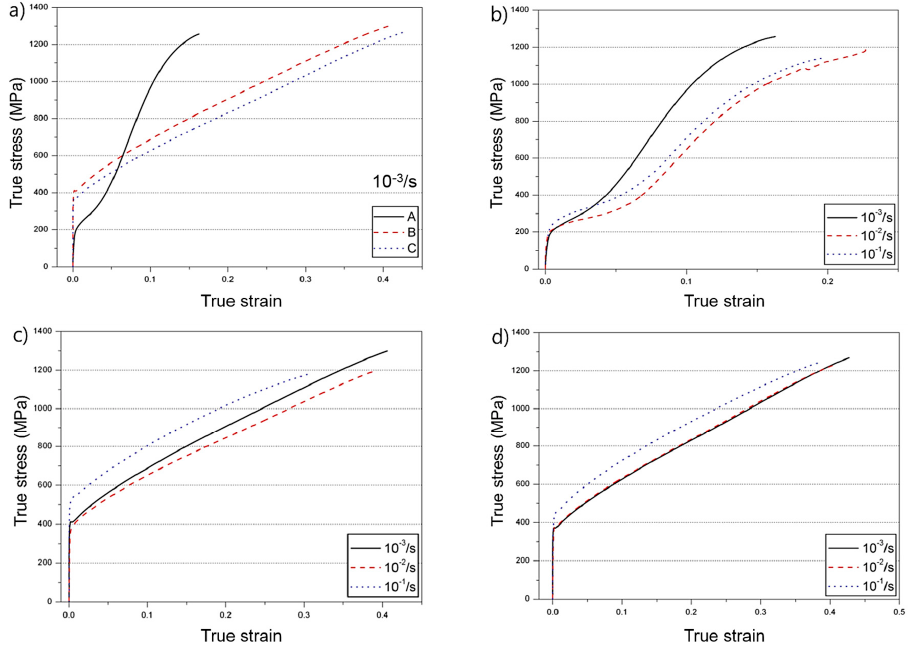
Figure 4. True stress-strain curves and speicimen A, B and C ( a ); ( b – d ) shows the effect of strain rate in specimen A, B and C respectively.